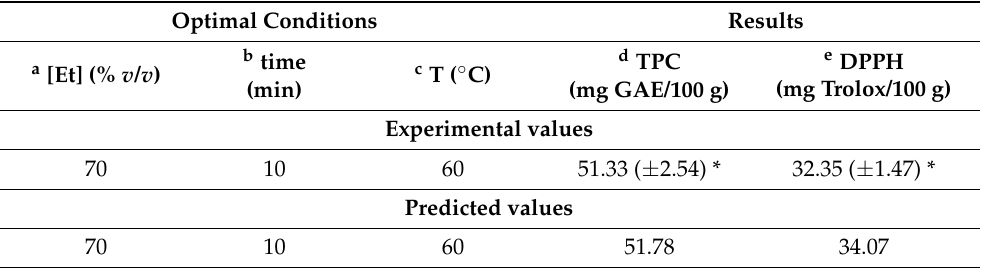
Table 4. Experimental and predicted values of total polyphenols content and DPPH radical scaveng- ing activity at the optimal UAE conditions.